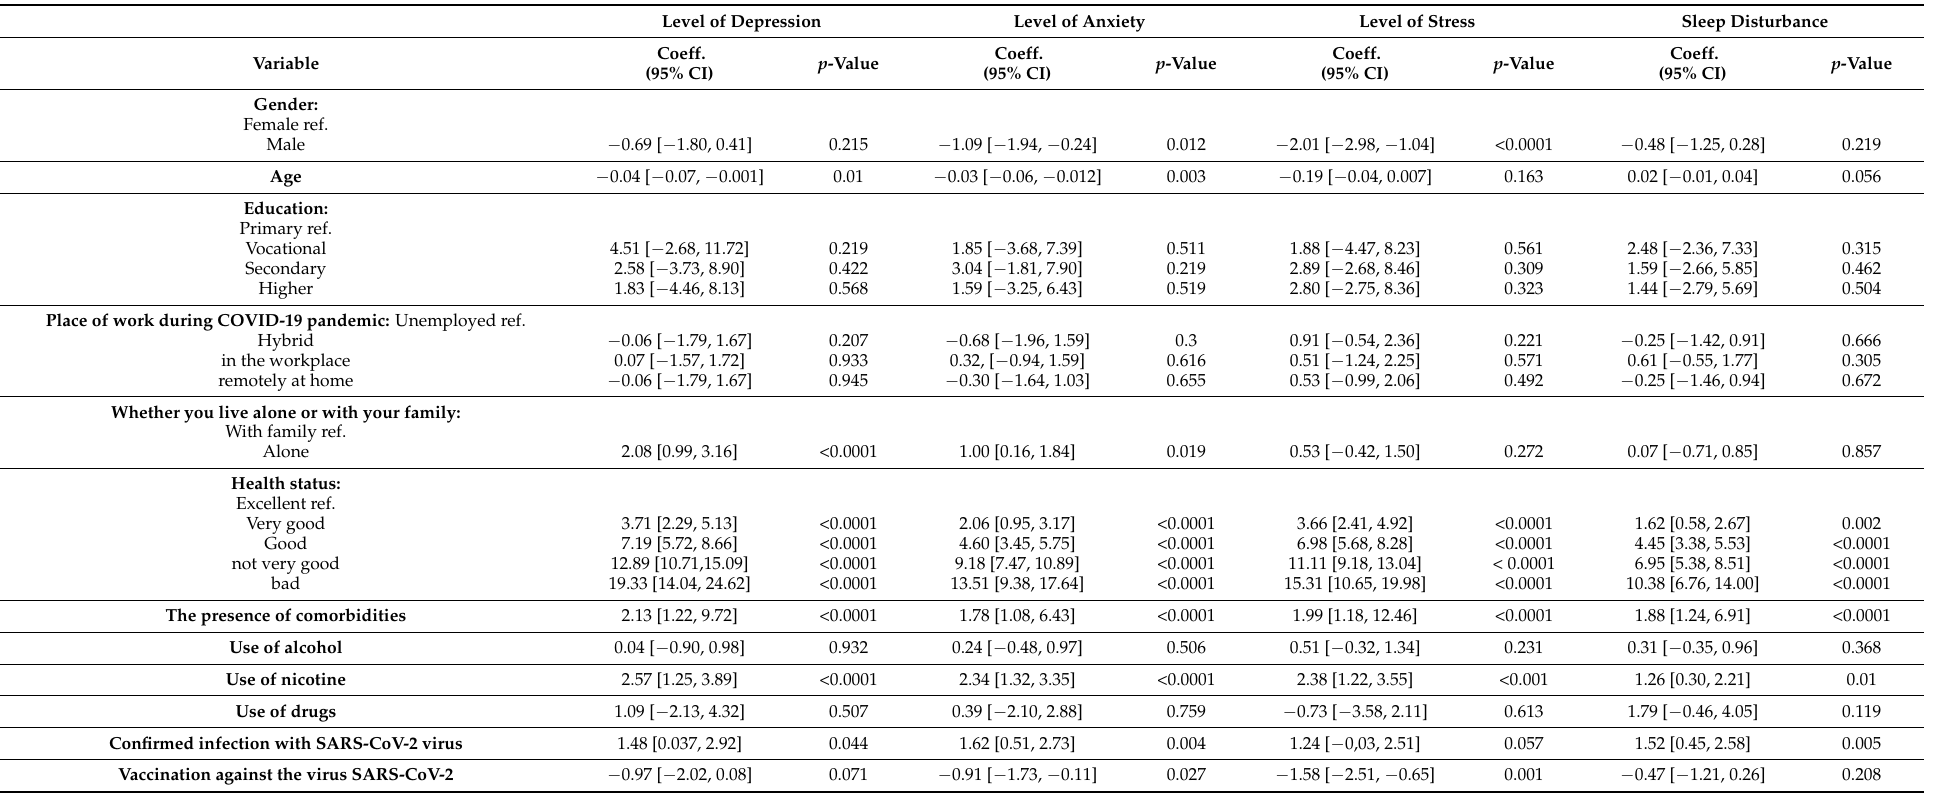
Table 4. Regression univariable analysis for the psychiatric symptoms outcome: depression, anxiety, and stress and sleep disturbance among Poles during the COVID-19 pandemic. Level of Depression Level of Anxiety Level of Stress Sleep Disturbance Variable Coeff. (95% CI) p -Value Coeff. (95% CI) p -Value Coeff. (95% CI) p -Value Coeff. (95% CI) p -Value Gender: Female